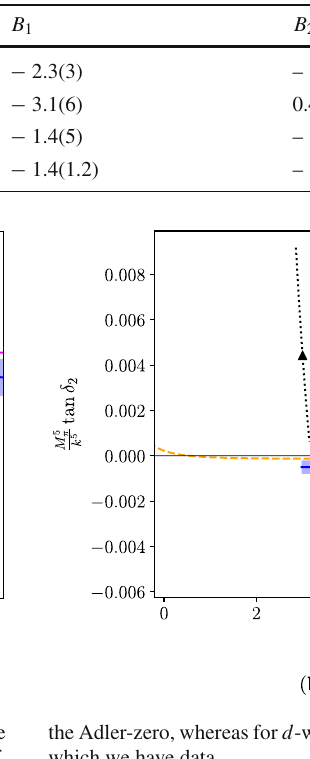
spondence of an energy level to a phase shift point [6,7].